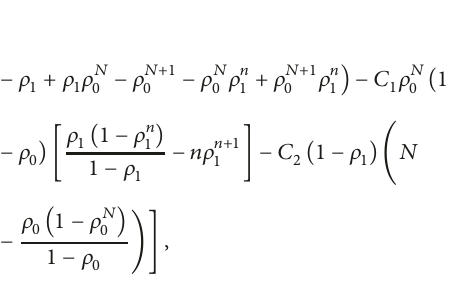
Figure 3: State transition diagram for the fully observable